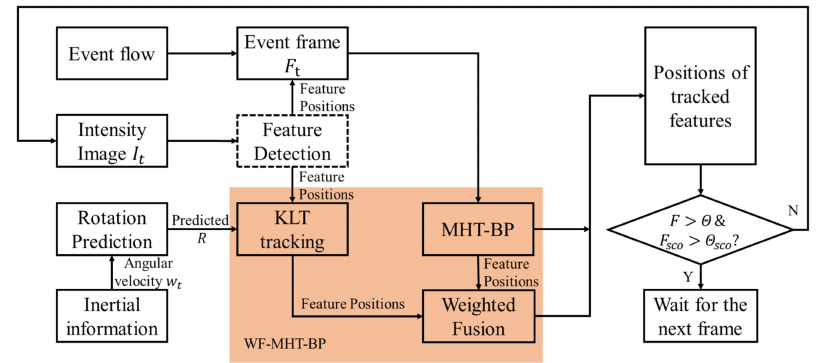
Figure 2. Flowchart of data stream and the proposed method